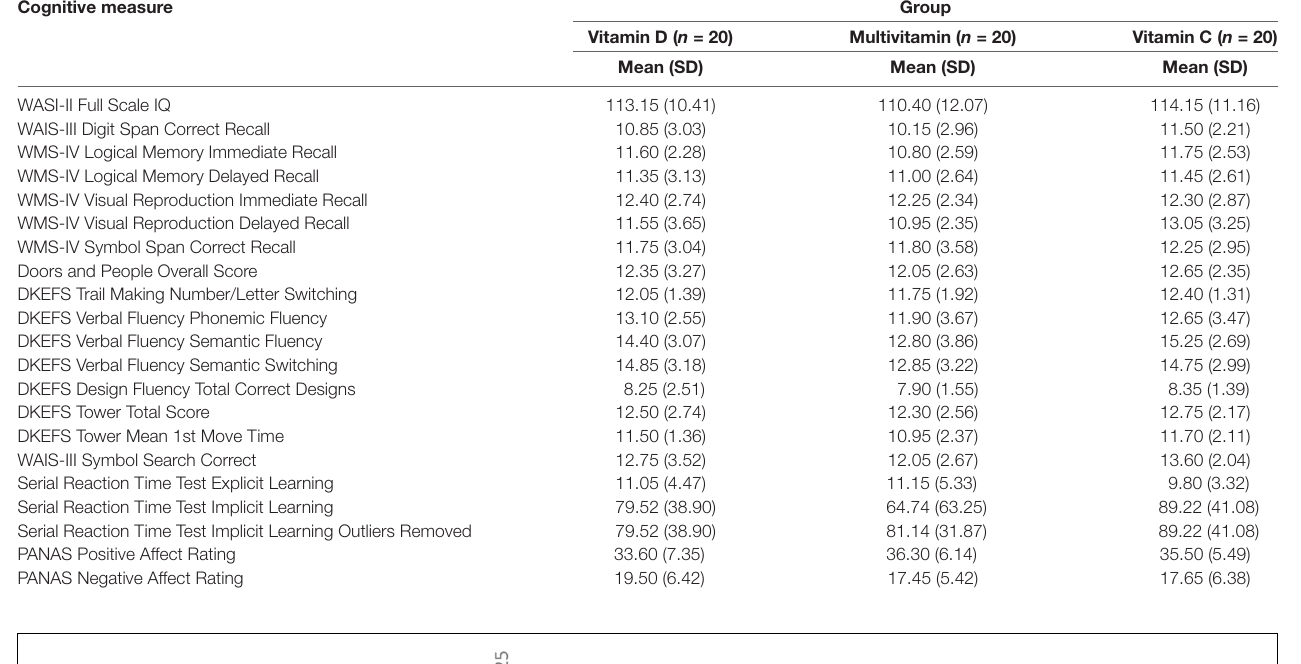
TABLE 1 | Descriptive statistics of baseline cognitive task performance by group.